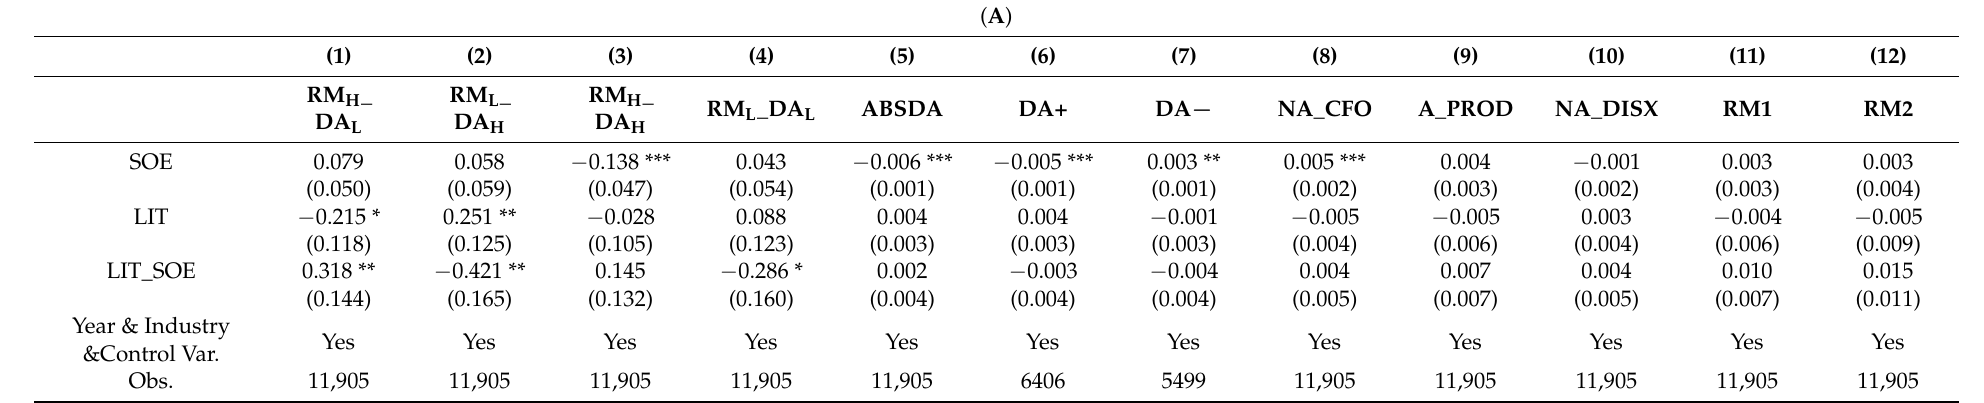
Table 11. The Joint Effects of State Ownership and Litigation on Earnings Management. Panel ( A ) Regressions on SOEs, Panel ( B ) Regressions on CSOEs and